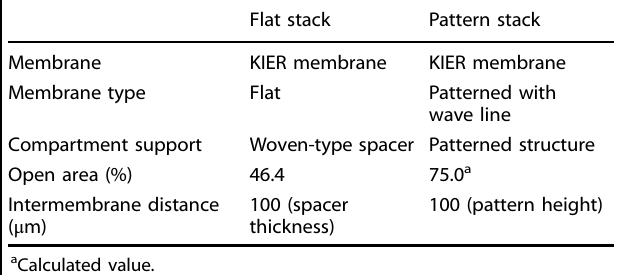
Table 3. Con fi guration of the reverse electrodialysis stacks used in this